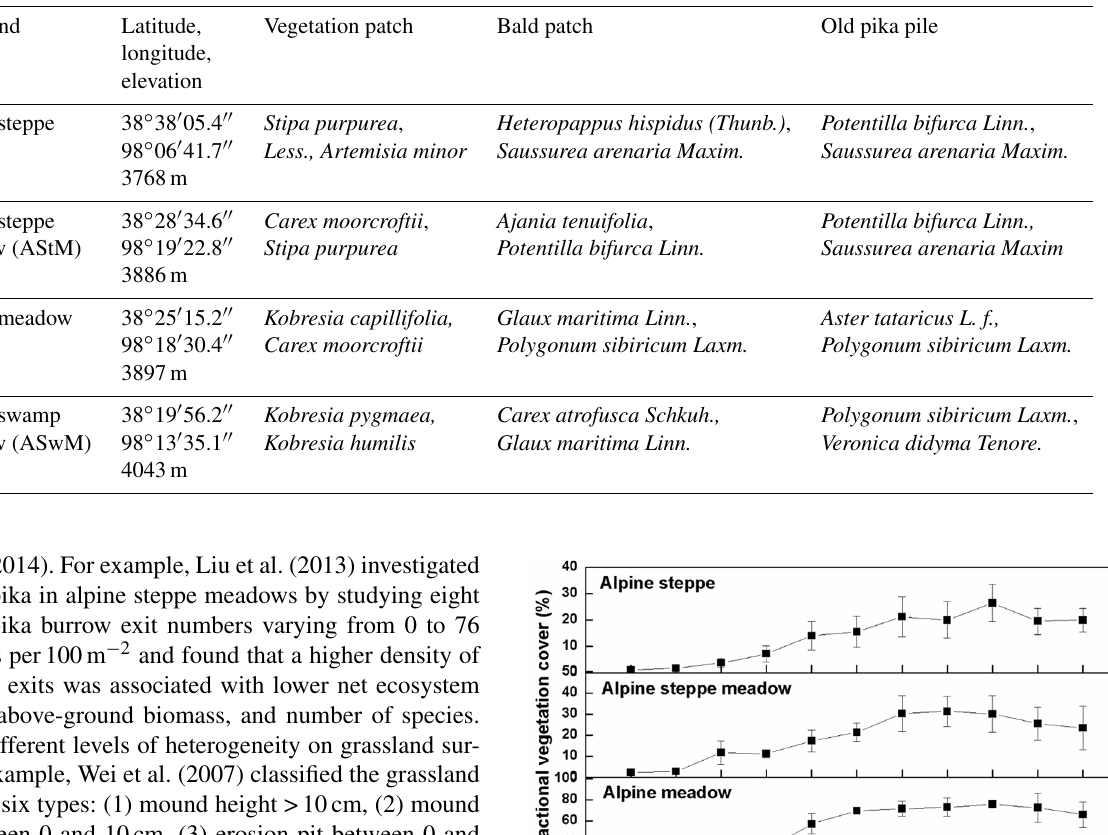
Table 1. The latitude, longitude, and elevation of four different types of alpine grassland and the dominant species on different surface types of each grassland.